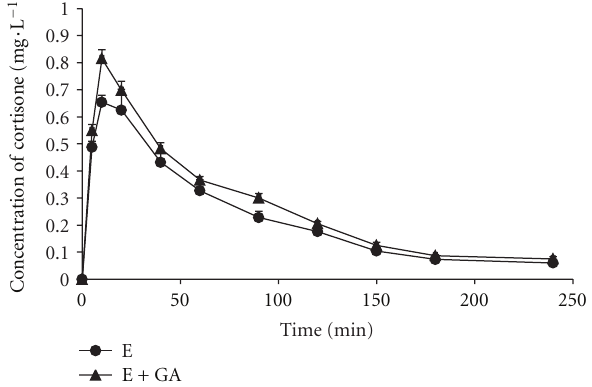
00.511.522.533.54